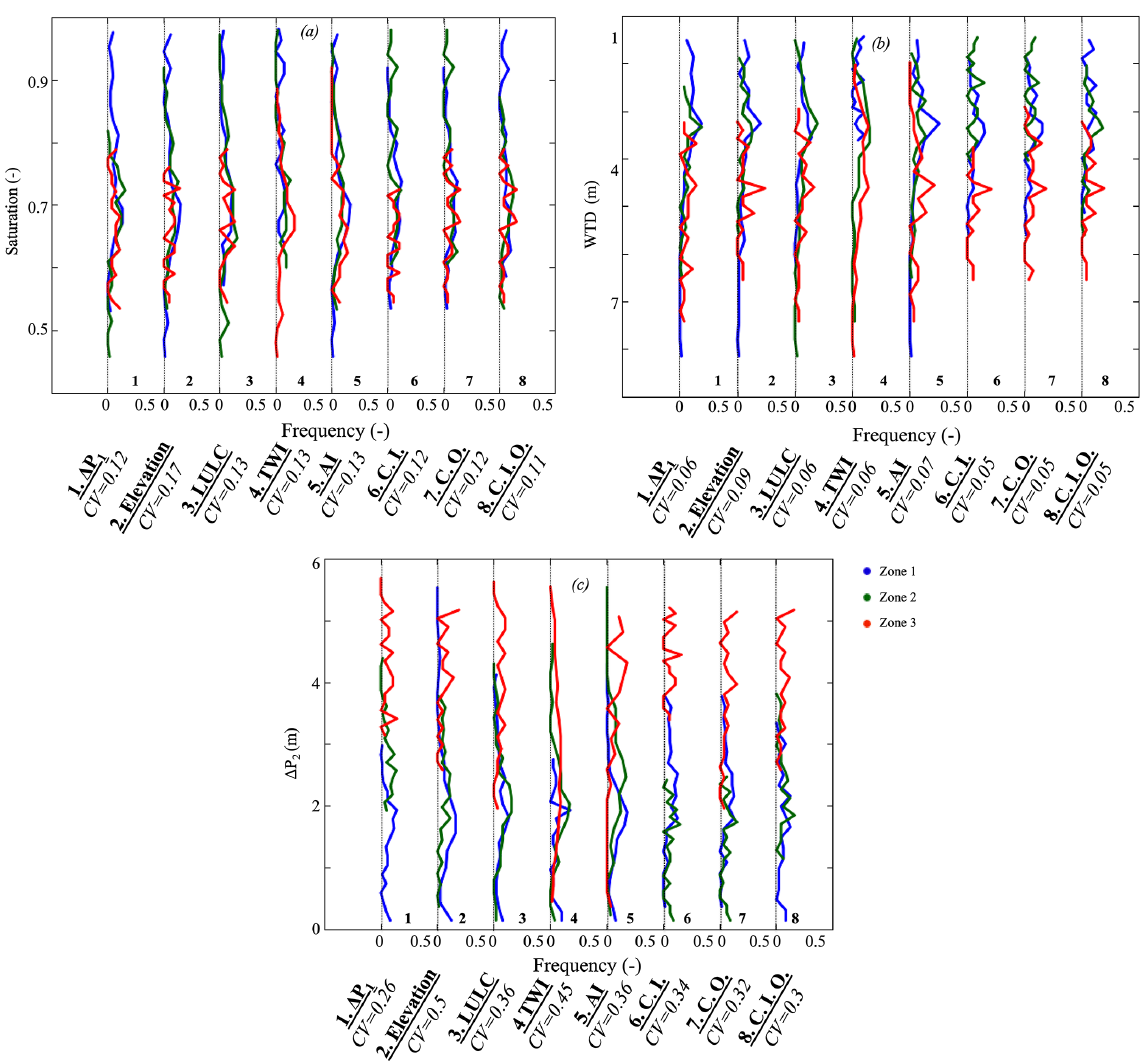
Figure 9. Frequency distributions of hillslope (a) saturation, (b) WTD, and (c) (cid:49)P 2 . Clustering approaches are based on (cid:49)P 1 , elevation, land cover (LULC), topographic wetness index (TWI), aridity index (AI), and machine-learning approaches (with inputs C.I., outputs C.O., and inputs and outputs C.I.O.). Hillslope clustering approaches are located across the x axis. Note that we plotted the distributions of the eight clustering approaches on the same graph and between each dotted line (frequency from 0 to 0.5) the frequency distributions of the three zones derived from the clustering are